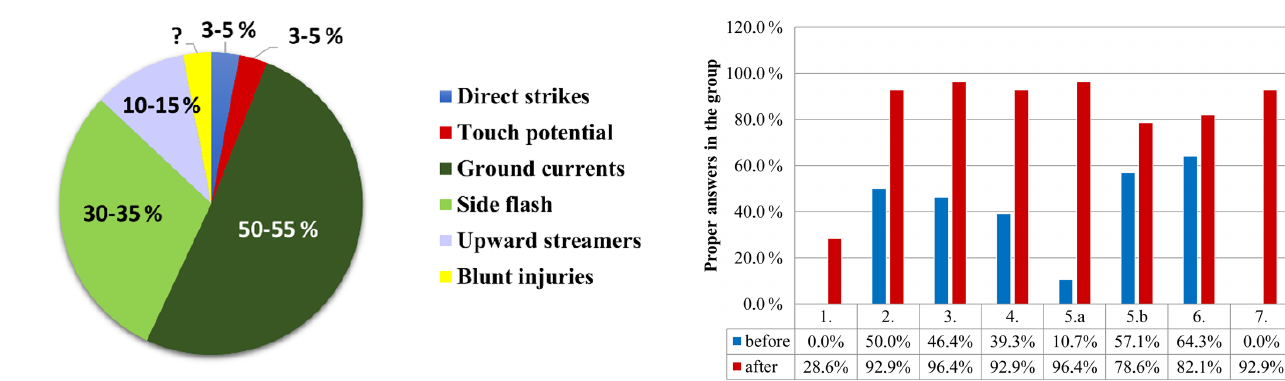
Figure 5. Students’ responses in pre-and